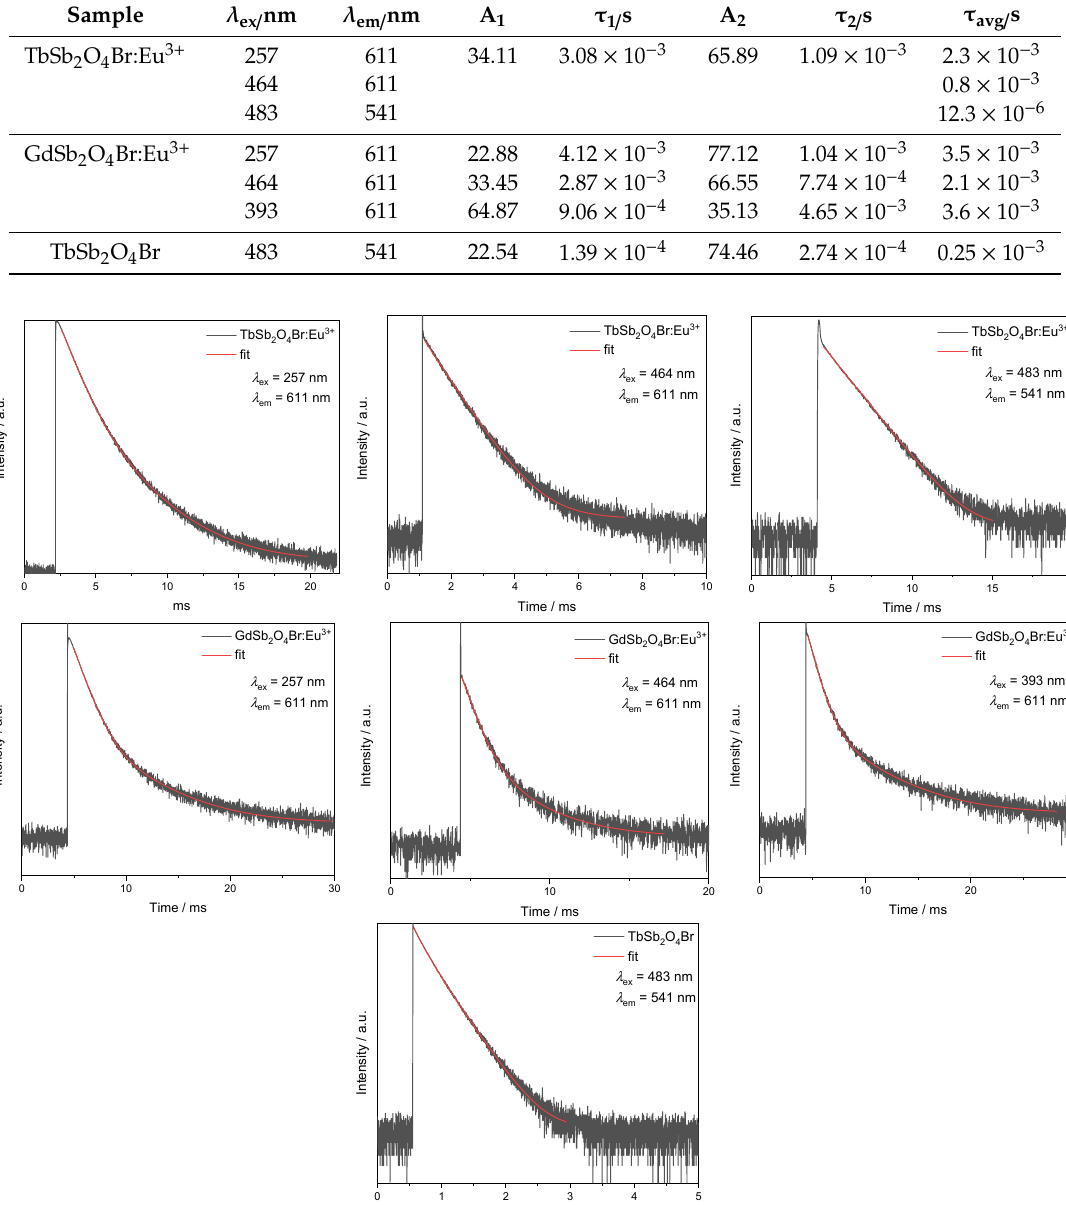
Table A5. Components and the average time of the multi-exponential decays reported in the manuscript. For the single-exponential decays, the fitted lifetime is reported as only the average value.